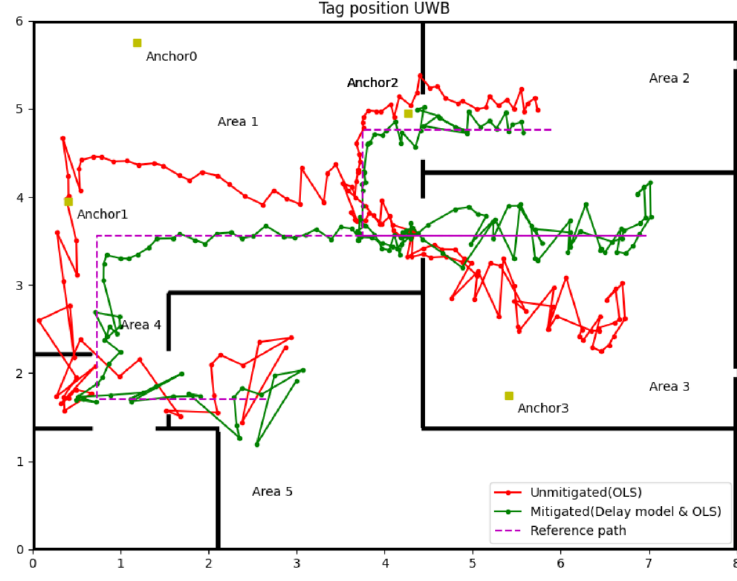
Figure 9. Tag position after mitigating by delay model with OLS. Table 4. Position accuracy analysis for delay model.